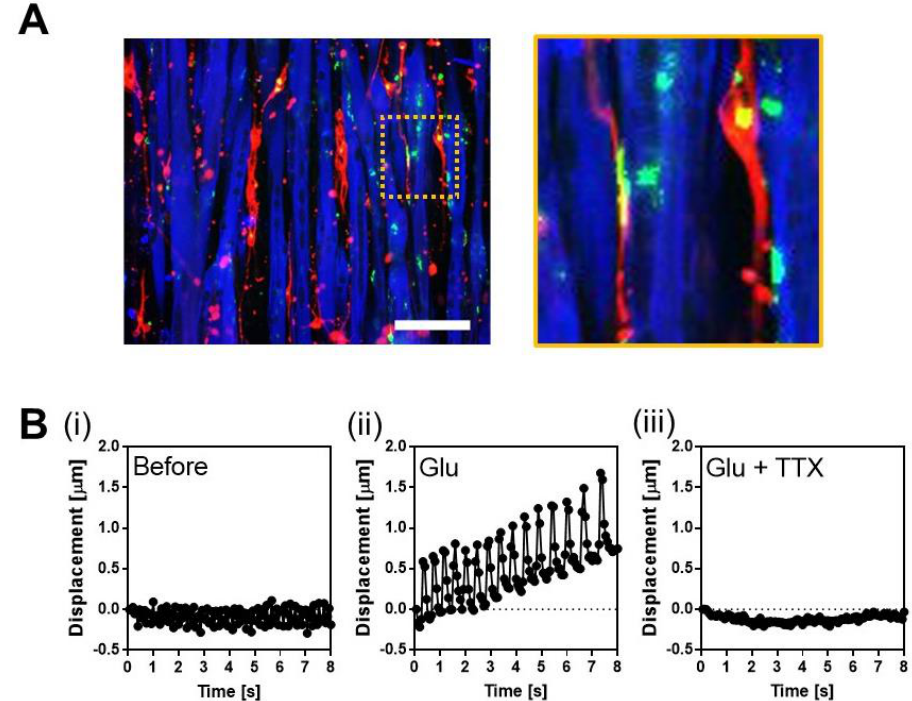
Table 2. Comparison of the number of functional NMJ observed in co-culture models of human SkM myotubes and human iPSC-derived MNs.